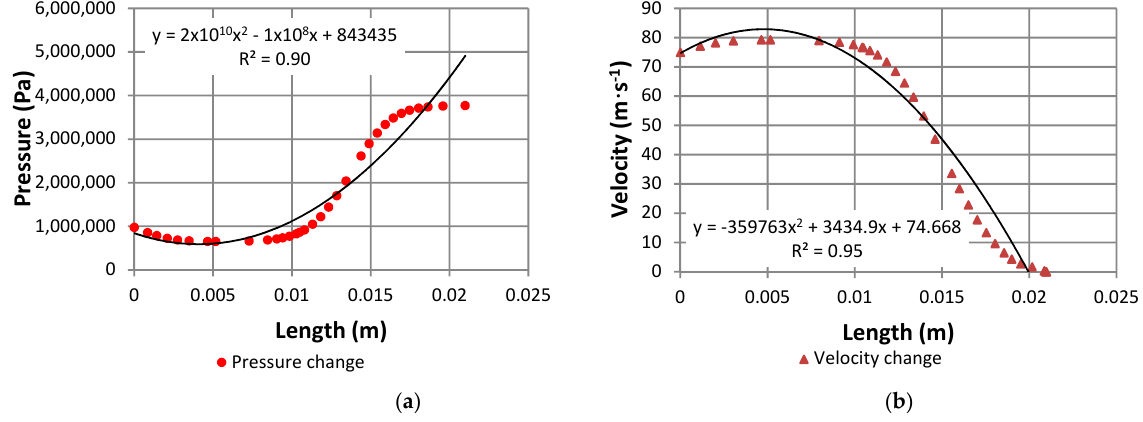
Figure 11. The variation curves of pressure ( p ) ( a ) and velocity ( υ ) ( b ) for a 0.0033 m 3 ·s -1 volume flow rate (200 L·min -1 ).